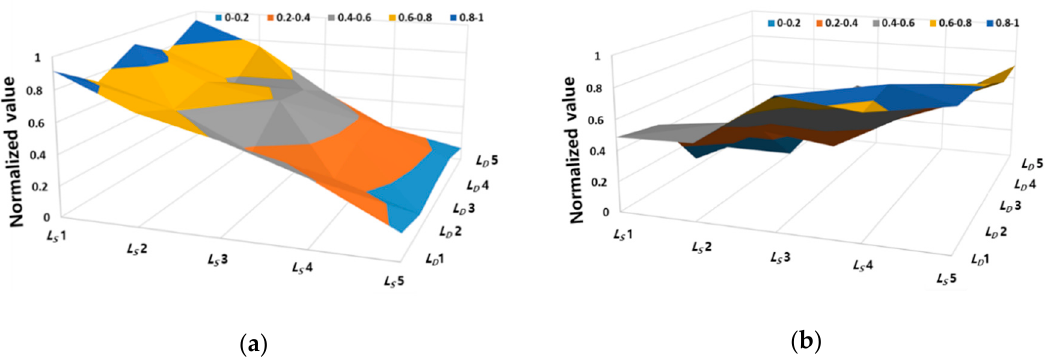
Figure 6. Relationships between L S and L D and working time and quality: ( a ) Relationship between working time ( L S -T) and work quality ( L S -Q) according to L S level; ( b ) relationship between working time ( L D -T) and work quality ( L D -Q) according to L D level.